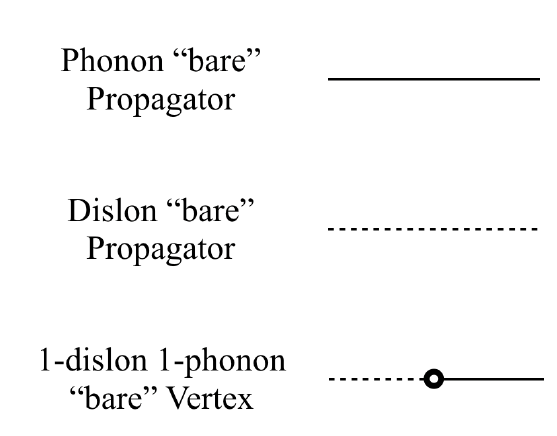
Figure 1. The basic diagrammatic expressions to be used in solving the quadratic theory. The upper two diagrams describe the basic propagator (Green’s function) for each type of excitation in the solid, with a continuous line for phonons and a dashed line for dislons. The third diagram represents the quadratic phonon–dislon interaction, allowing for quantum of excitations of one type to be converted into the other.